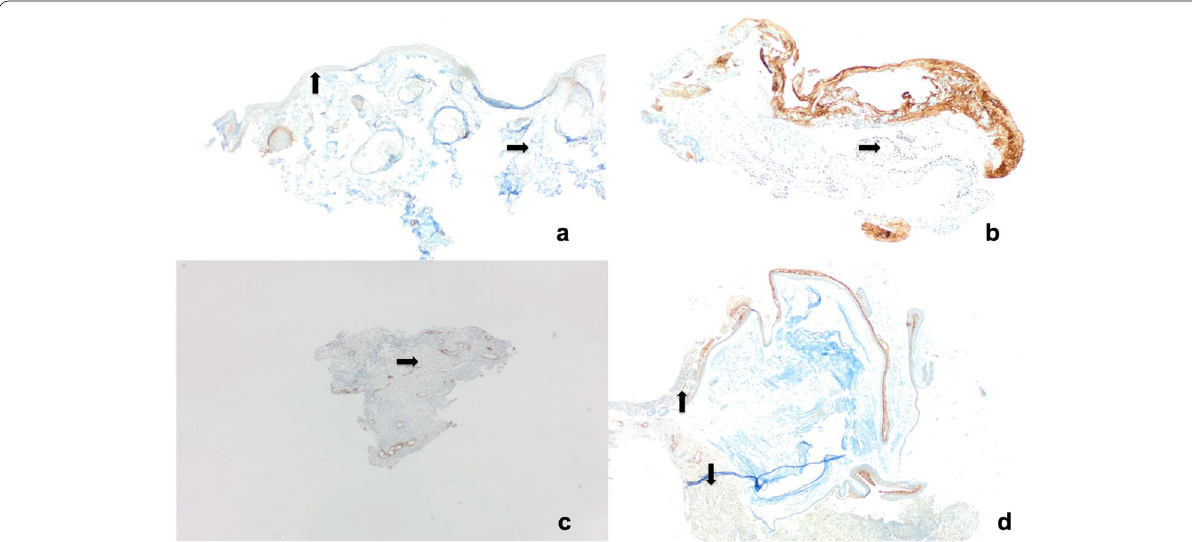
Fig. 3 a Outer ear canal skin (Tenascin-C IHK x40): epithelial staining score 0, stroma 0. b Avivation tissue (Tenascin-C IHC x40): no epithelial staining score, stroma . c Granulation tissue (Tenascin-C IHC x40): epithelial staining score 0, stroma ++ epithelial staining score 0, stroma